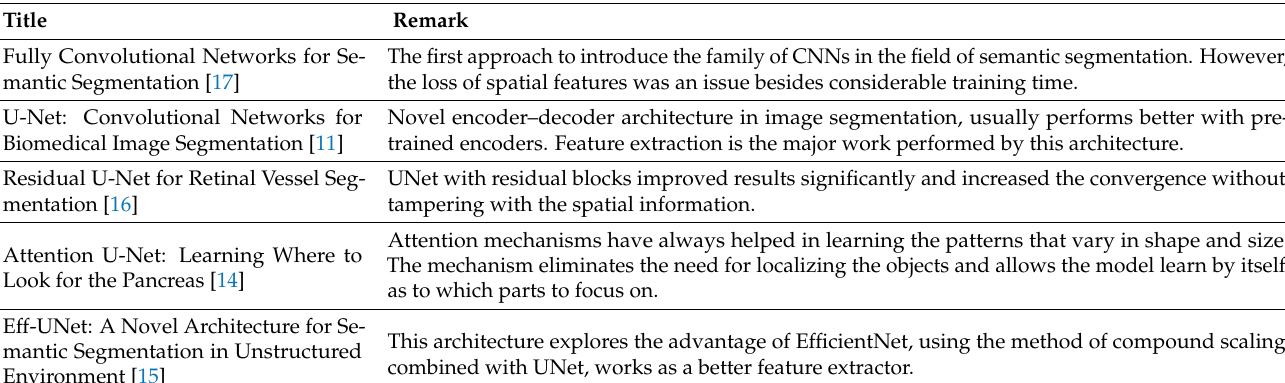
Table 1. Previous